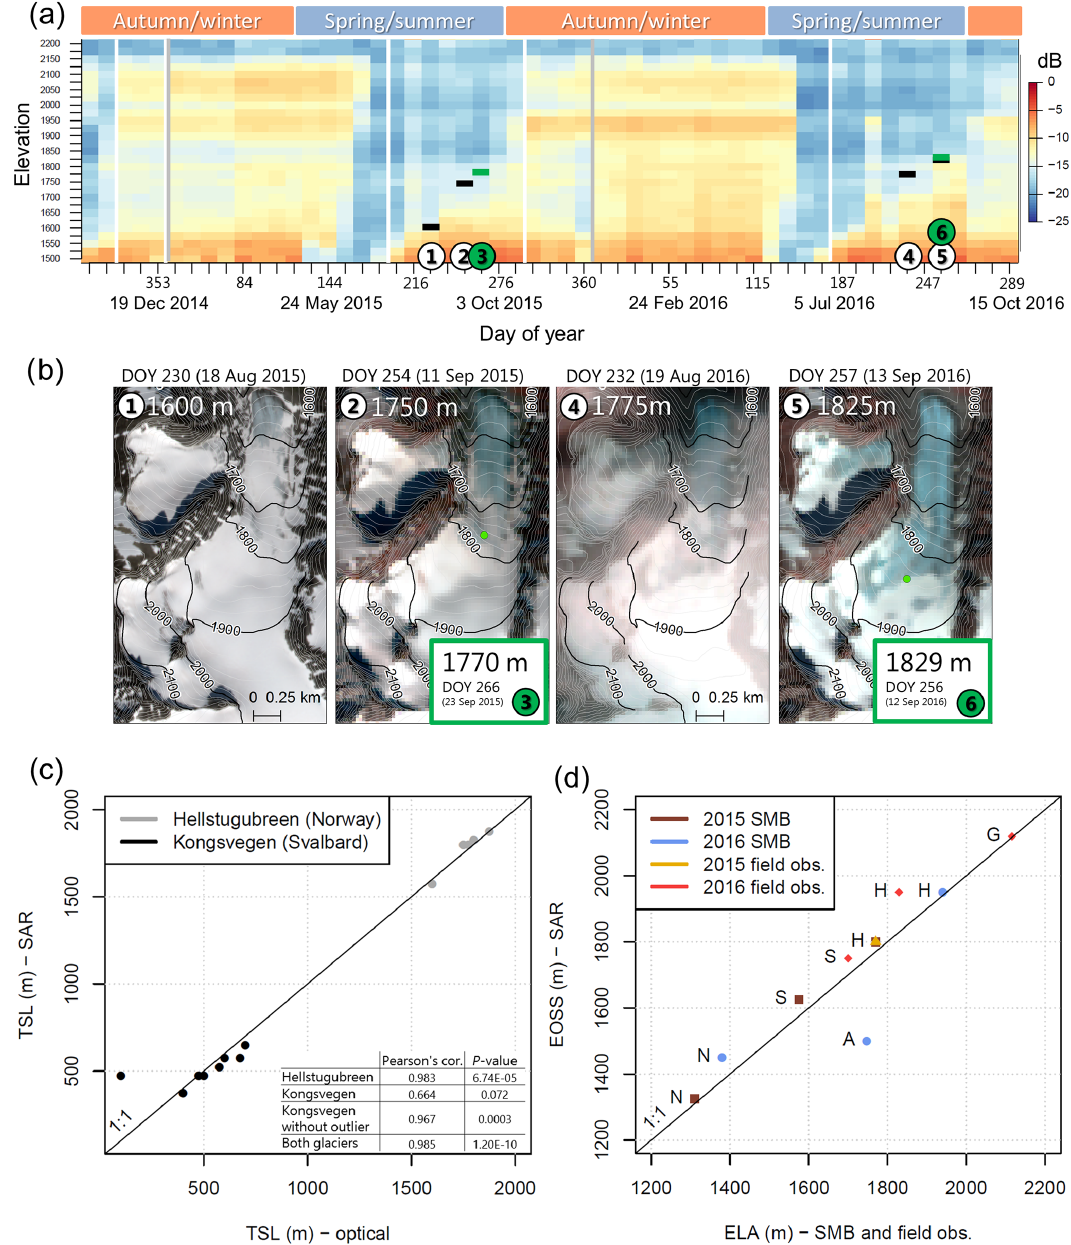
Figure 3. (a) Time series of Sentinel-1A and B backscatter images where mean dB values have been calculated for elevation zones of 25m ( y axis). White lines indicate missing Sentinel-1A scenes. Grey lines separate between years. The stripe of low backscatter data in the upper part is due to areas in the radar shadow. Note: images from 3 to 15 October 2016 (DOY 277 to 289) are Sentinel-1B acquisitions with 6-day repeat time. (b) Elevation of TSL from optical satellite imagery, corresponding to the numbers in panel (a) . Sentinel-2A image is from 18 August 2015 (DOY 230), while the rest are Landsat 8 images. Green points and boxes are in situ EOSS derived from handheld GPS. (c) Manually picked TSLs from optical and SAR images acquired almost on the same day (Table A2). The maximum difference in acquisition dates between sensors is ± 6 days. (d) Plot of EOSS from SAR and ELA from the surface mass balance (SMB) gradients and EOSS from field observations (Pearson’s correlation coefficient: 0.92, p value: 0.00015). Abbreviations: A is Austdalsbreen, S is Storbreen, H is Hellstugubreen, G is Gråsubreen and N is